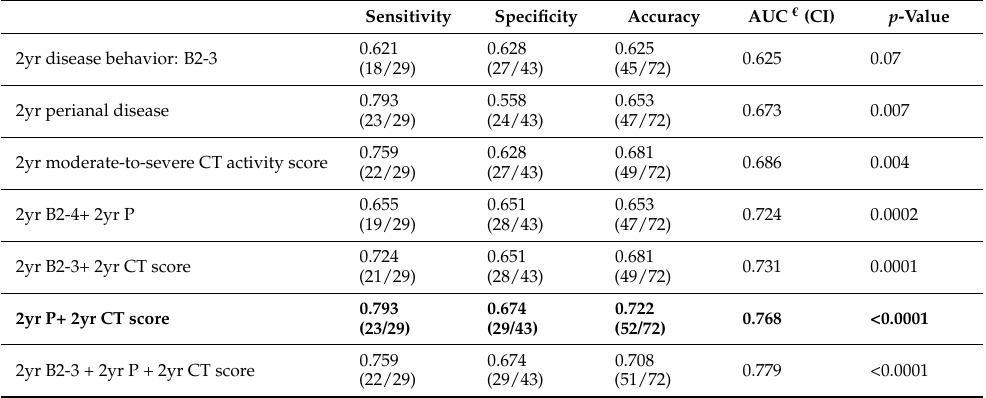
Table 5. ROC curve for sensitivity analyses for unfavorable disease course.